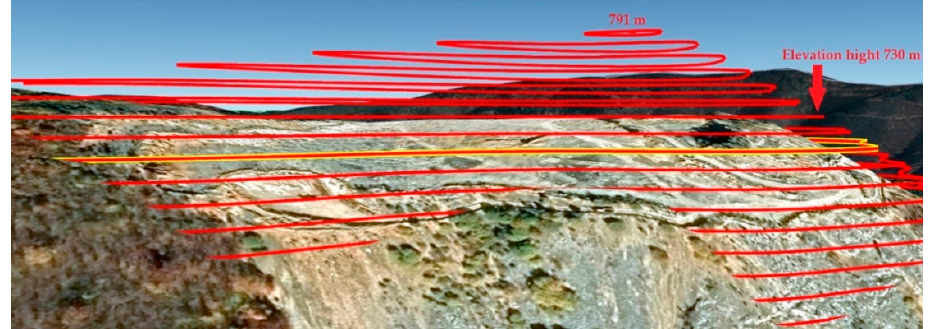
Figure 12. Graphical representation of rock mass loss (adapted from Google Earth, earth.google.com/web/).